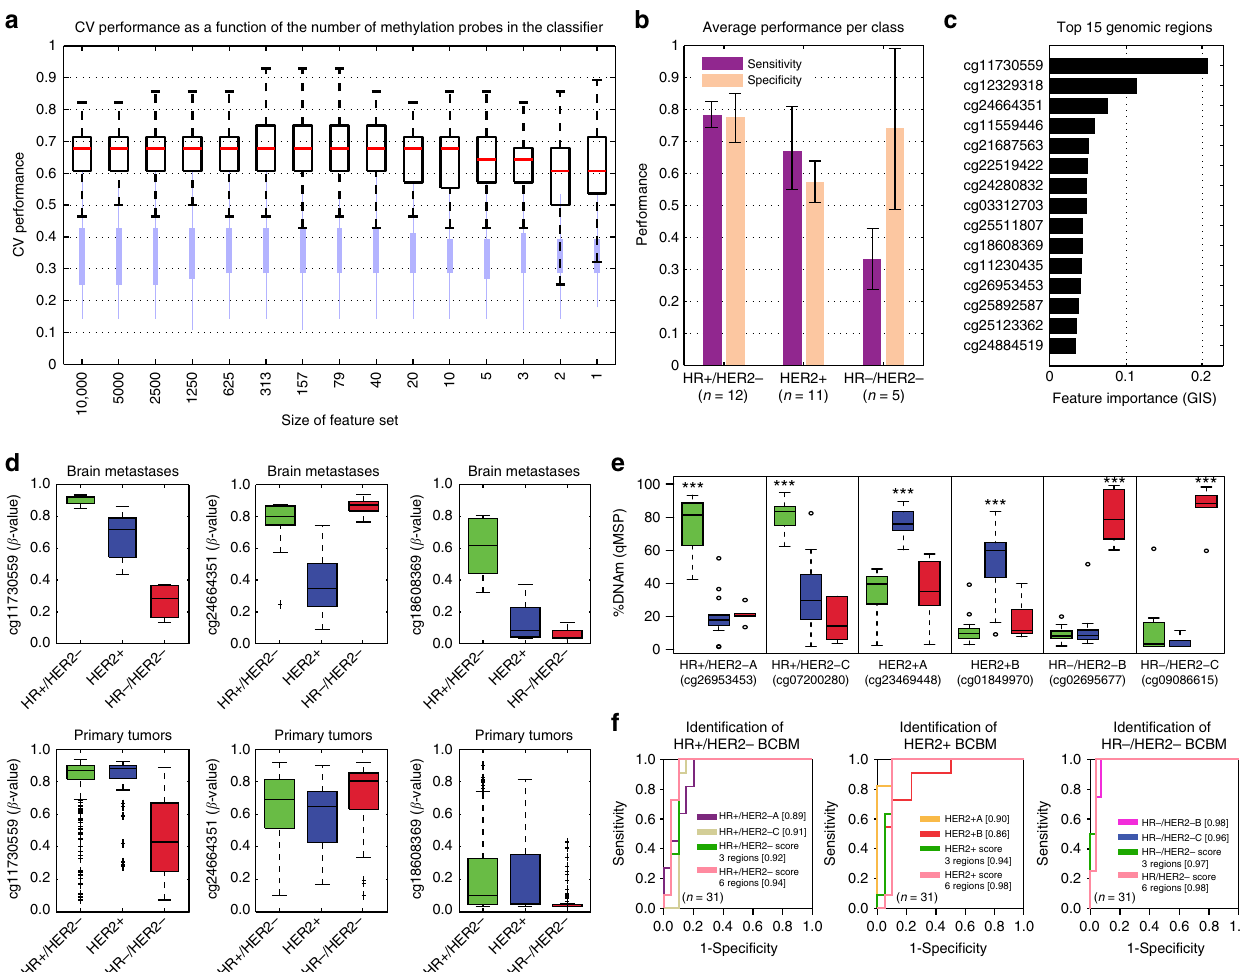
Fig. 5 A DNA methylation-based classi fi er to predict BCBM subtypes. a Boxplots describing the CV performance across 100 repeats for RF classi fi ers to predict breast cancer subtypes. From left to right, decreasing numbers of features were used to construct the model ( x -axis). The top and bottom of each box represent the fi rst and third quartile, respectively; the internal red line represents the median values. Light blue bars depict the performance based on permuted class labels and represent the random background distribution. b Bar plots depicting the prediction performance as measured by sensitivity and speci fi city for each of the three subtypes. The bars show the average performance and interquartile range (error bars) across all models with 10 features or more across all repeats (HR + /HER2 − ; n = 12, HER2 + ; n = 11, and HR − /HER2 − ; n = 5). c Bar plots depicting the RF feature importance (mean decreases in Gini impurity score; GIS) of the 15 most predictive regions averaged across all models with 10 or more features and across all repeats. d Boxplots of DNAm levels ( β -values) across our cohort strati fi ed by subtypes (HR + /HER2 − ; n = 12, HER2 + ; n = 11, and HR − /HER2 − ; n = 5) and TCGA-BRCA cohort of primary breast tumors strati fi ed to match our molecular subtype de fi nitions (HR + /HER2 − ; n = 443, HER2 + ; n = 83, and HR − /HER2 − ; n = 117). Differences in the DNAm levels among the groups were statistically signi fi cant for all the cases (Kruskal – Wallis test; P -value < 0.0001). e DNAm levels assessed by qMSP for six genomic regions with differential DNAm among the three BCBM subtypes ( n = 31). ***Wilcoxon test; P -value < 0.001. f ROC curves showing the prediction potential for the breast cancer subtypes ( n = 31) for each of the six differentially methylated regions and combinations of three or six regions into BCBM molecular subtype-speci fi c scores: HR + /HER2-score = DNAm level of HR + /HER2 − minus DNAm level of HER2 + minus DNAm level of HR − /HER2; HER2 + score = DNAm level of HER2 + minus DNAm level of HR + /HER2 − minus DNAm level of HR − /HER2; and HR − /HER2-score = DNAm level of HR − /HER2 − minus DNAm level of HR + /HER2 − minus DNAm level of HER2 + ; see Supplementary Data 10 for